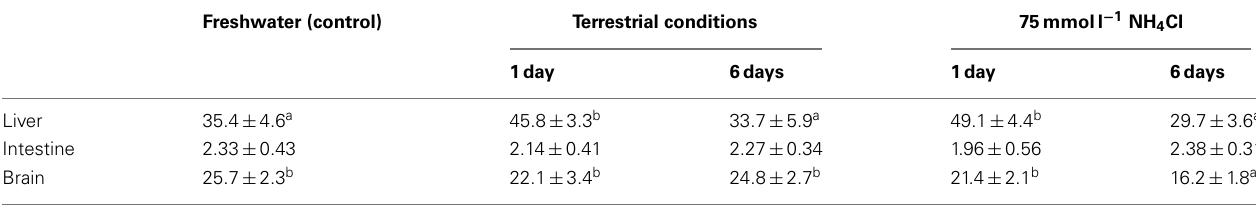
Table 3 |The amination activity ( μ mol NADH oxidized min − 1 g − 1 tissue) of glutamate dehydrogenase from the liver, intestine, and brain of Monopterus albus kept in freshwater (control) or after 1 day or 6days of exposure to terrestrial conditions or 75mmoll − 1 NH 4 Cl.